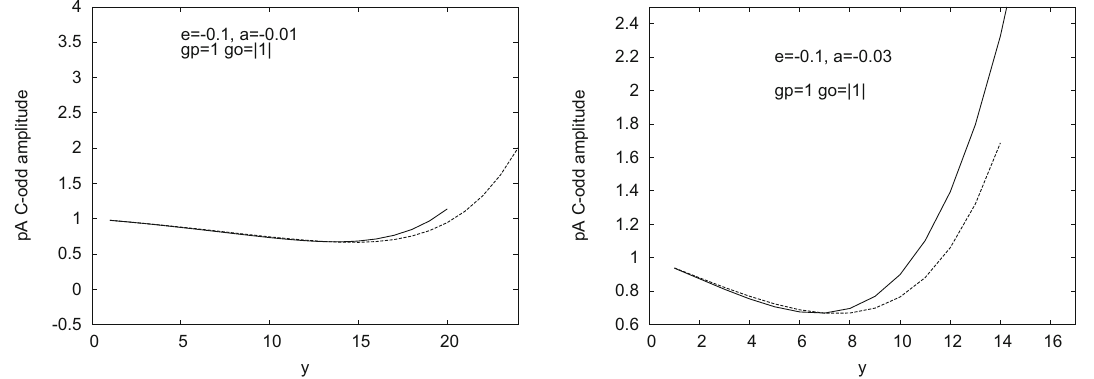
Fig. 3 pA C-odd amplitudes at different rapidities for μ p = 0 . 1, λ = 0 . 01 , 0 . 03 and g P = | g O | = 1. The lower curves correspond to summation of the fan diagrams